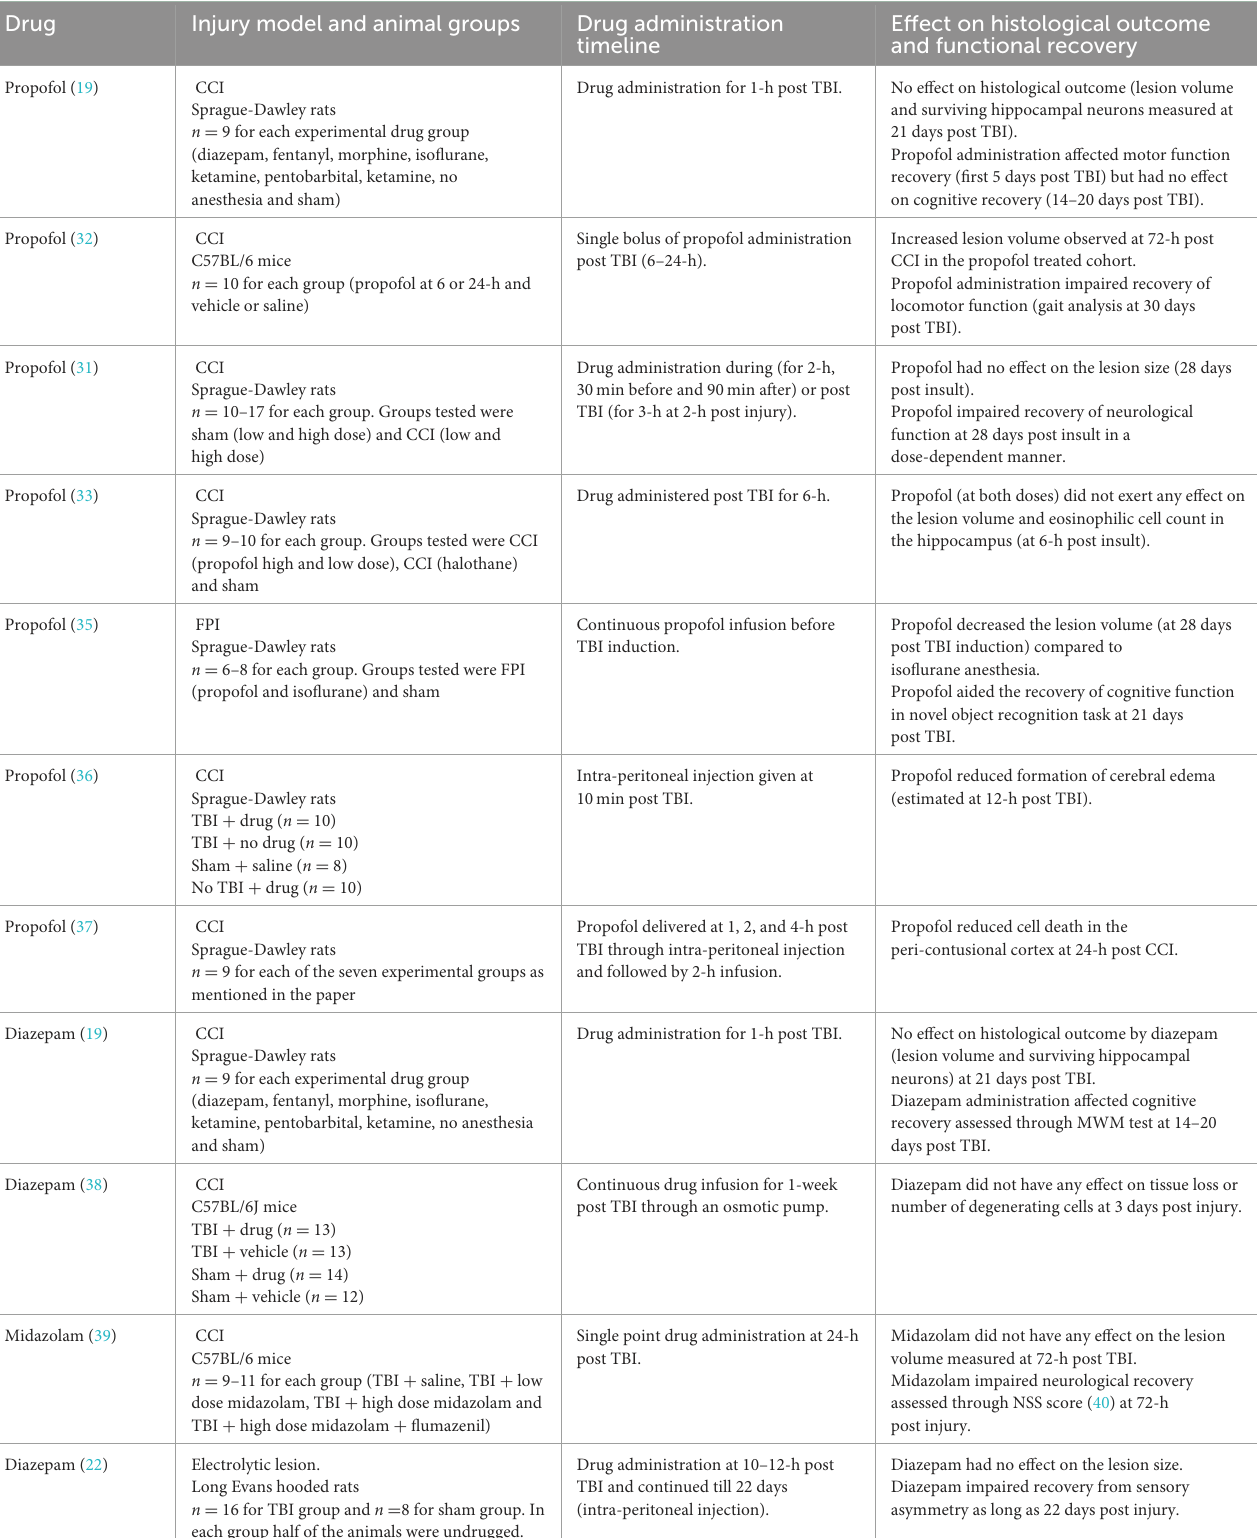
TABLE 1 List of preclinical studies involving drugs that target GABAergic neurotransmission in TBI. Drug Injury model and animal